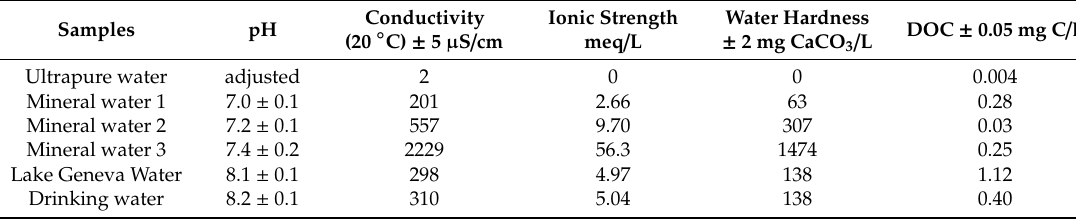
Table 1. Bottled mineral, drinking, and Lake Geneva water